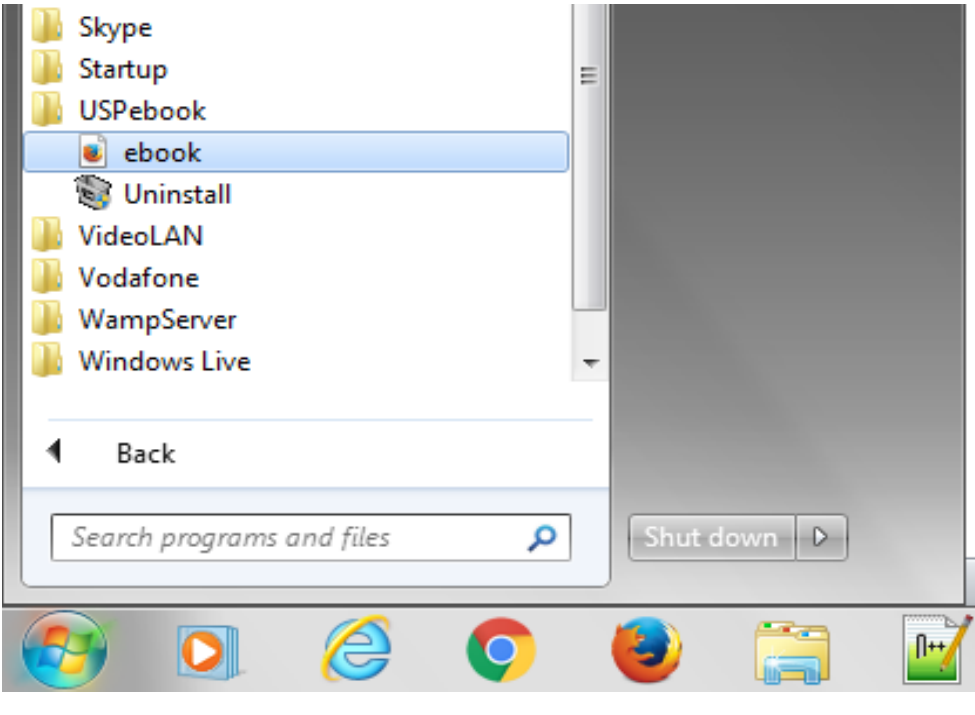
Figure 3. Textbook short cut from start menu.